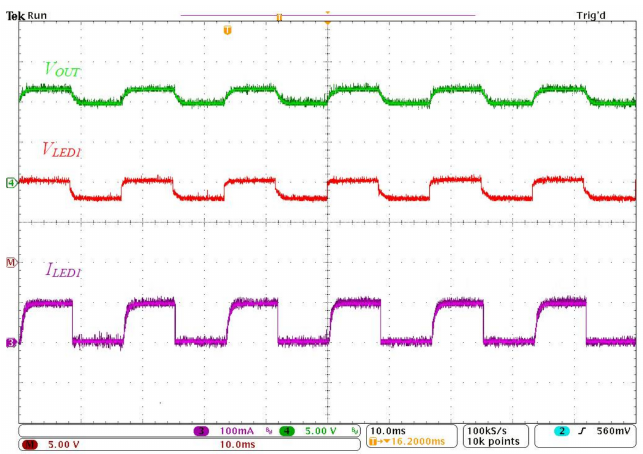
Figure 14. Measured waveform of LED string1.